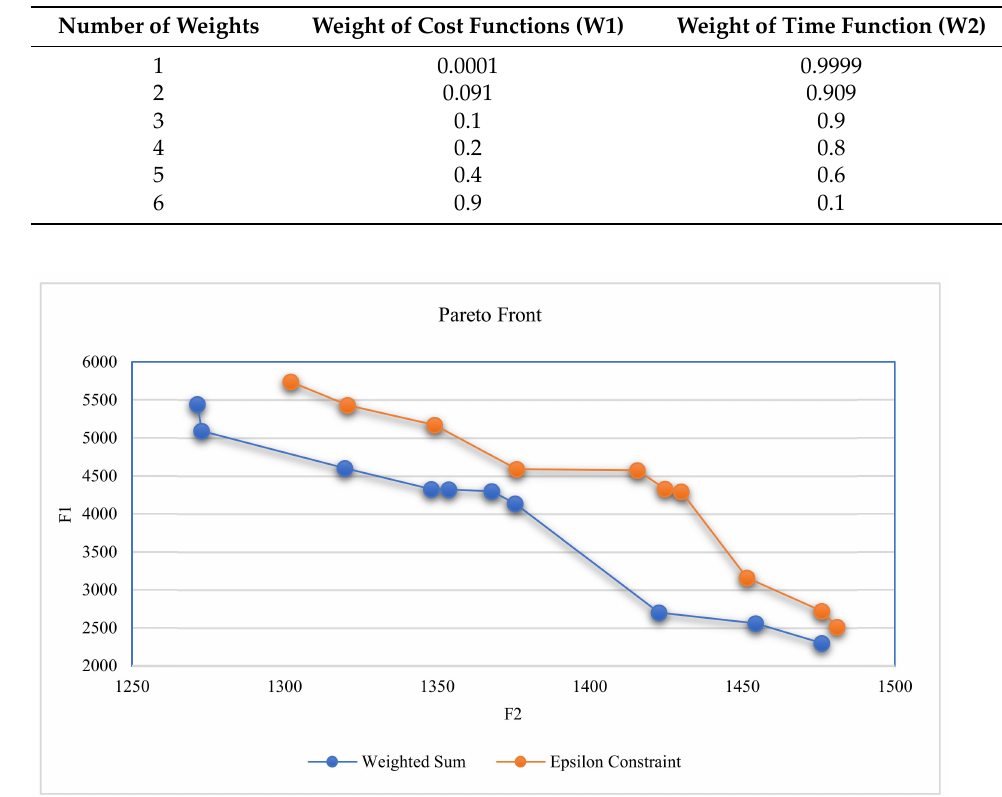
Figure 5. Pareto Front graph of ε ‑constraint and weighted sum